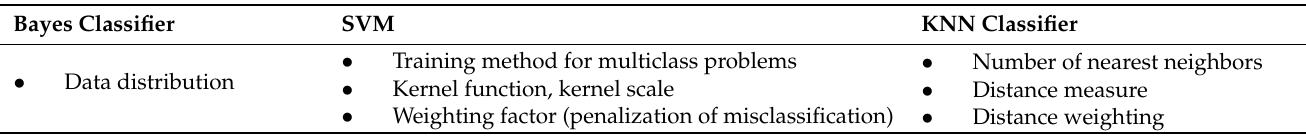
Table 4. Varying model parameters in the search for the optimal classification